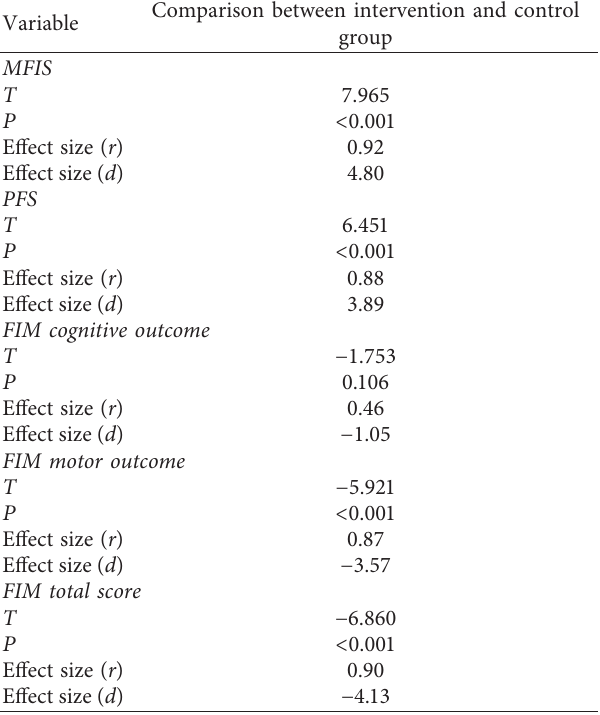
Table 3: Comparison between the case and control groups in PFS and FIM